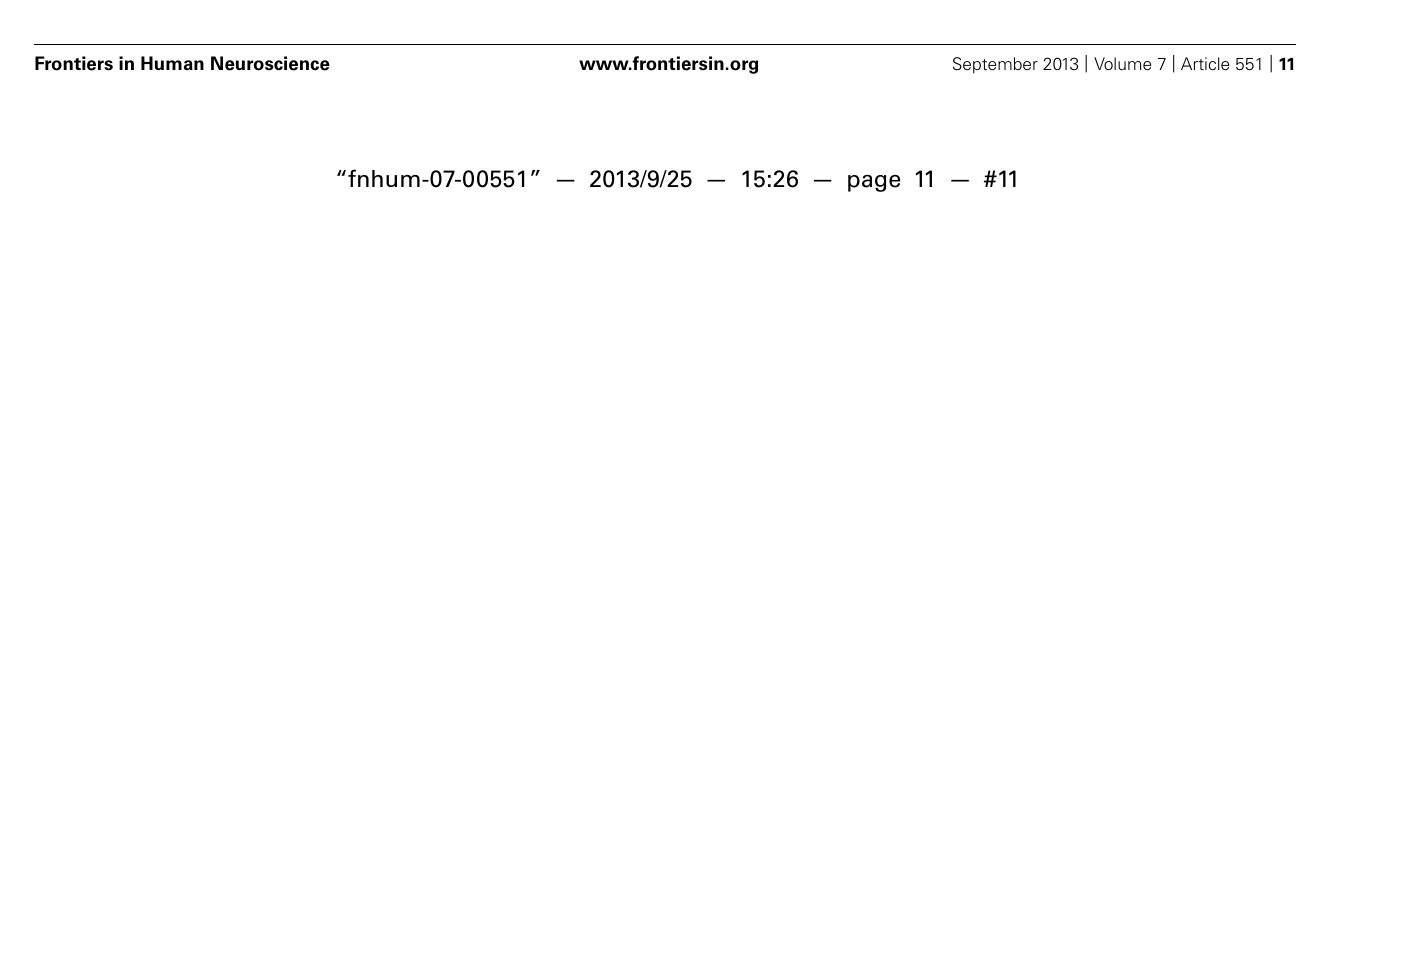
categorical processing that differs from linear or constant processing. Graphs in red squares represent dimensional (linear) processing with statistically significant correlations after the subject-wise validation ( Table 3 ). Graphs in gray squares represent constant processing without statistically significant correlations. Error bars denote SEM. R: the group-wise correlation coefficient. p (Valid.): the probability after the subject-wise validation ( Table 3 ). (A) The right fusiform face area (FFA); (B) the left insula; (C) the left amygdala; (D) the mPFC; (E) the right OFA; and (F) the posterior STS (pSTS) in the right